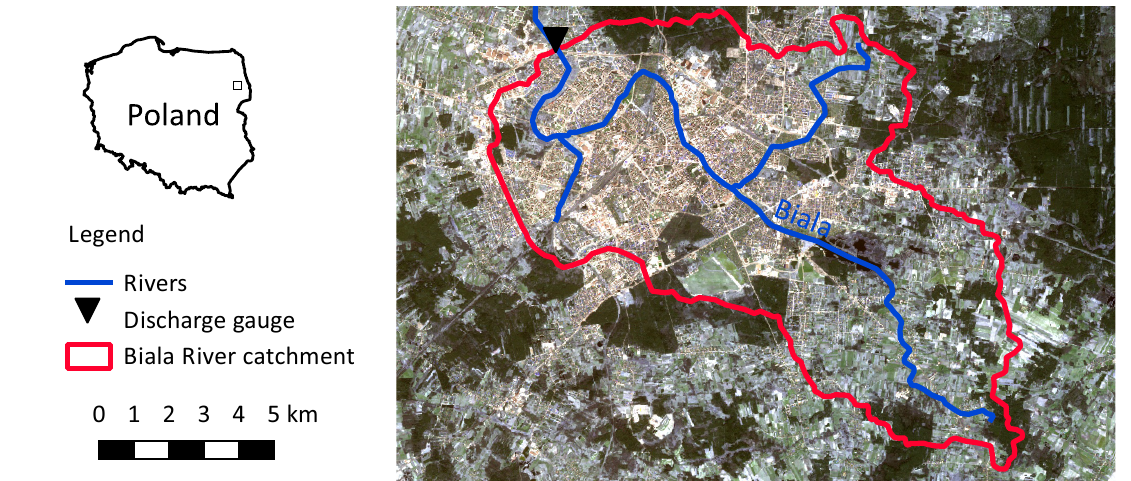
Figure 4. Biala River catchment with rivers and discharge gauge indicated. The background natural colour composition Sentinel 2 satellite image from 2017 presents urban areas in bright yellow and white, agriculture in bright green and grey and forest in dark green